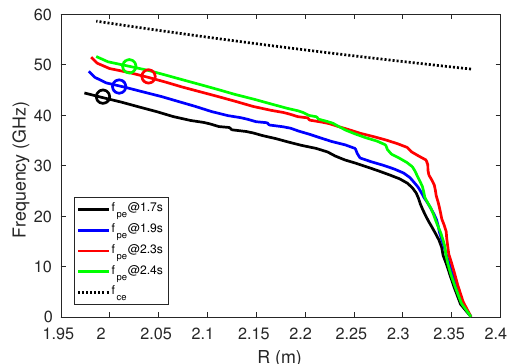
1.95 2 Figure 5: Comparison of the plasma frequency (solid lines) and the ω pe bursts frequency (circles, the posi- tion is determined assuming the frequency is ω pe ) (EAST #70444, magnetic axis ∼ 1.9 m). The electron density is measured by a microwave reflectometer.